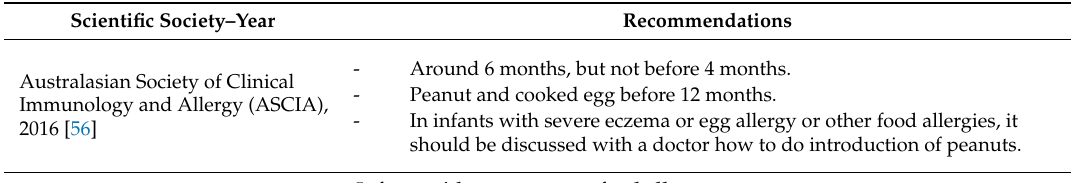
Table 2. Recent recommendations for food introduction to prevent food allergy in the general population and in infants at high